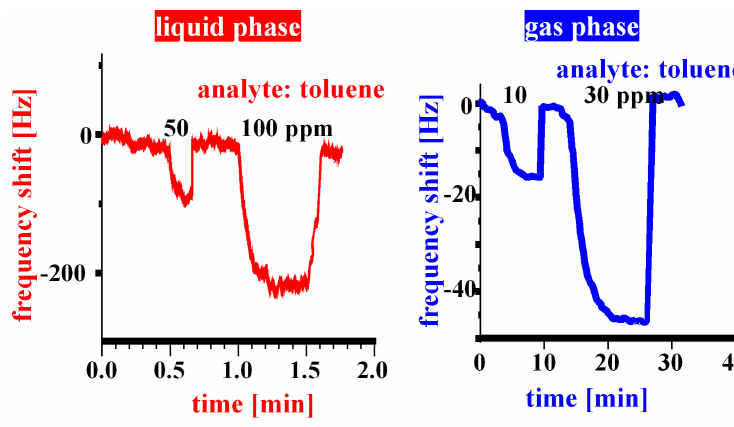
Figure 2: Sensor responses against toluene obtained in liquid and in gas